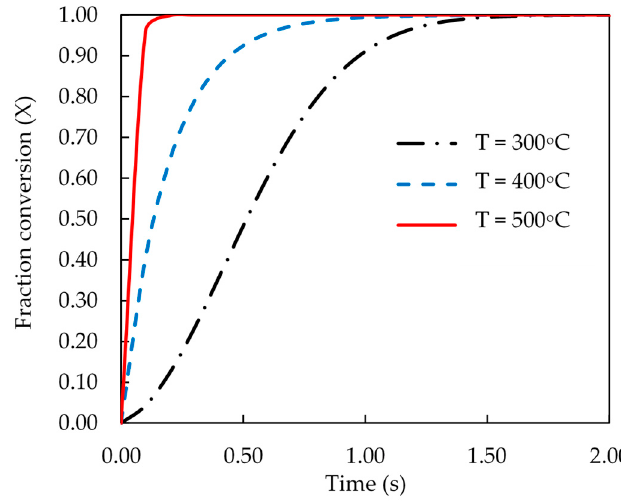
Figure 8. Effect of pyrolysis temperature on the computed fractional conversion of coconut shell as a function of time.